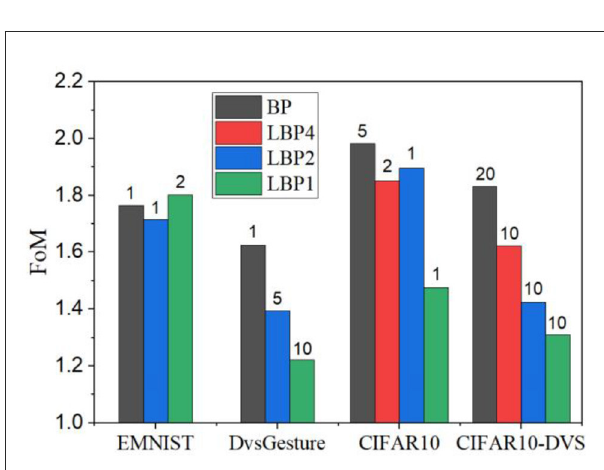
FIGURE14 FoMs for different local training methods on different datasets. For each local training method, the smallest FoM is selected. On top of each bar, the value represents the truncation